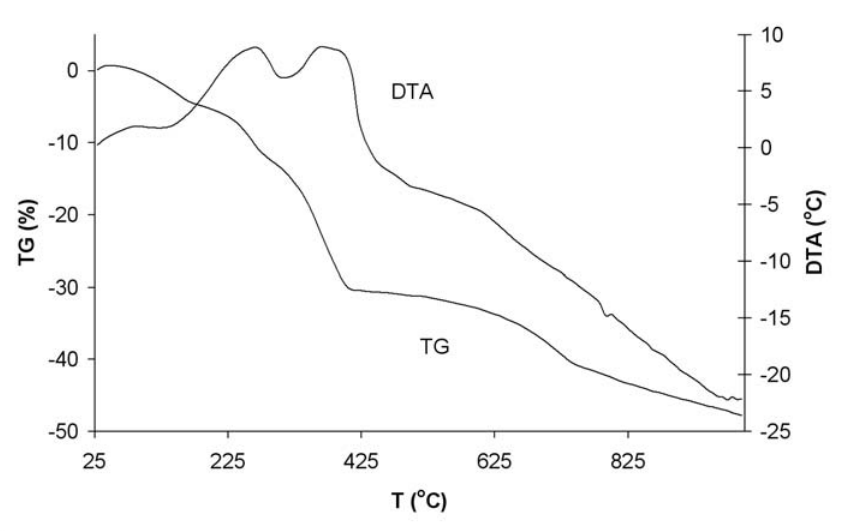
Fig. 5 Thermal decomposition (TG and DTA) curves of the silica-immobilised ( via hy- drogen bonding, SG–h–Cu-tren) Cu-tren complex.